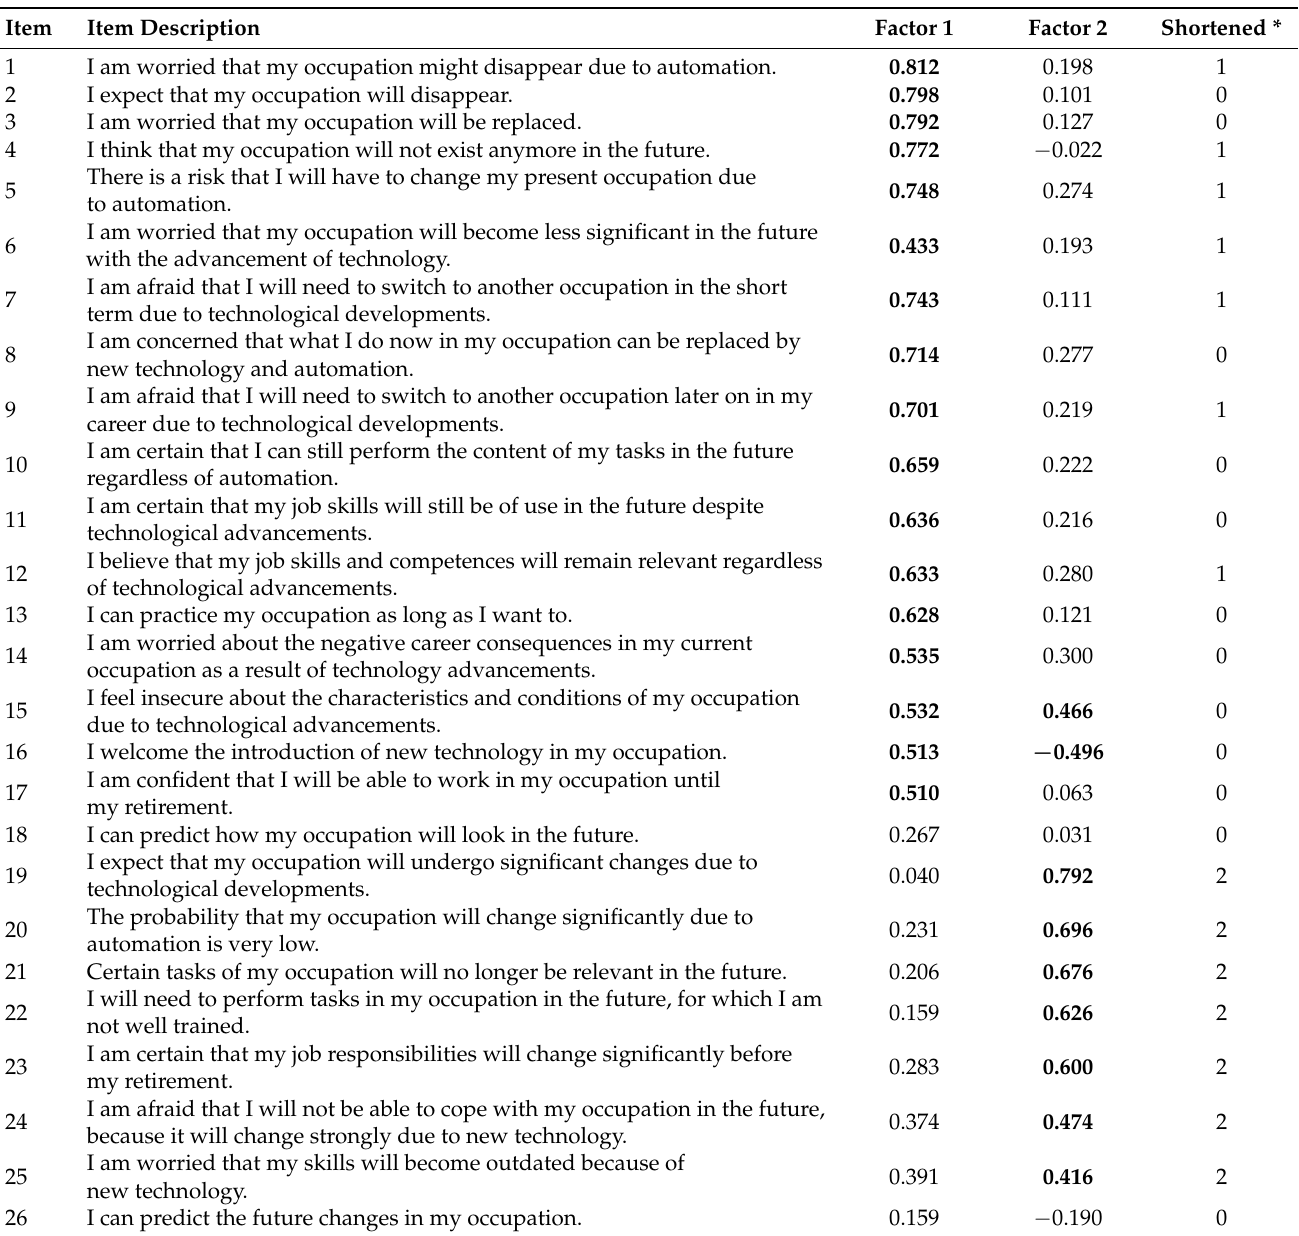
Table A2. Preliminary Selection of Items Resulting from the Pilot Study for a First Abbreviated Questionnaire Based on a Varimax Rotated Principal Component Analysis with Two